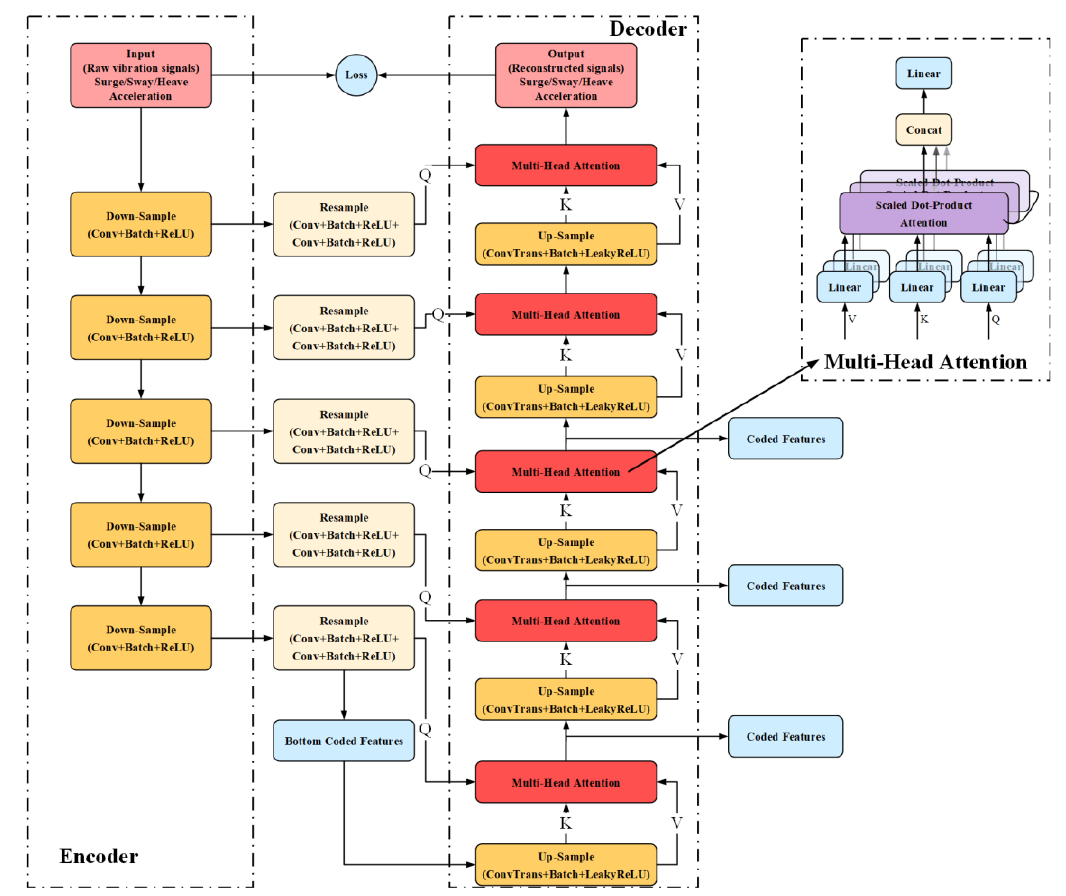
Figure 3. The MSCSA-AED